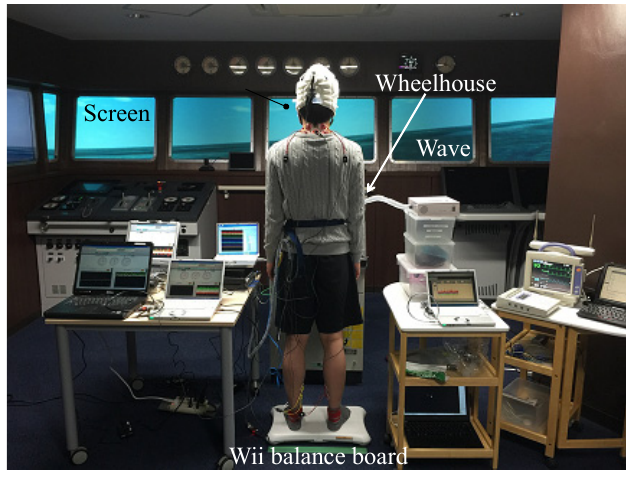
Figure 4. Experimental setup.